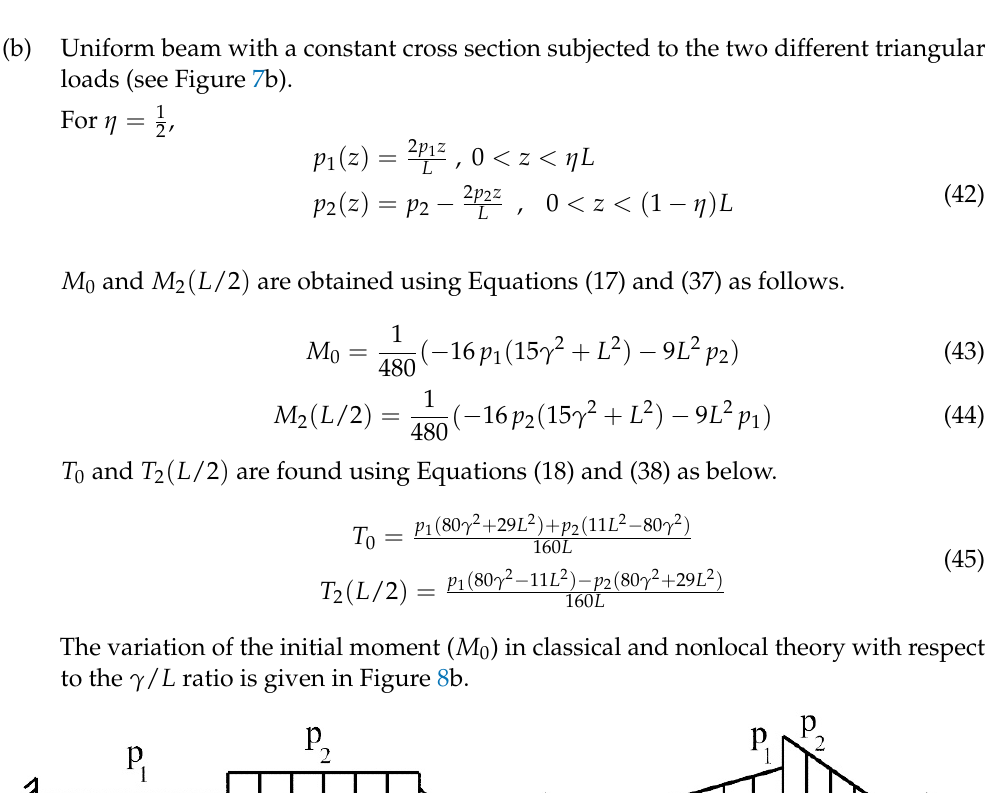
are obtained using Equations (17) and (37) as follows.